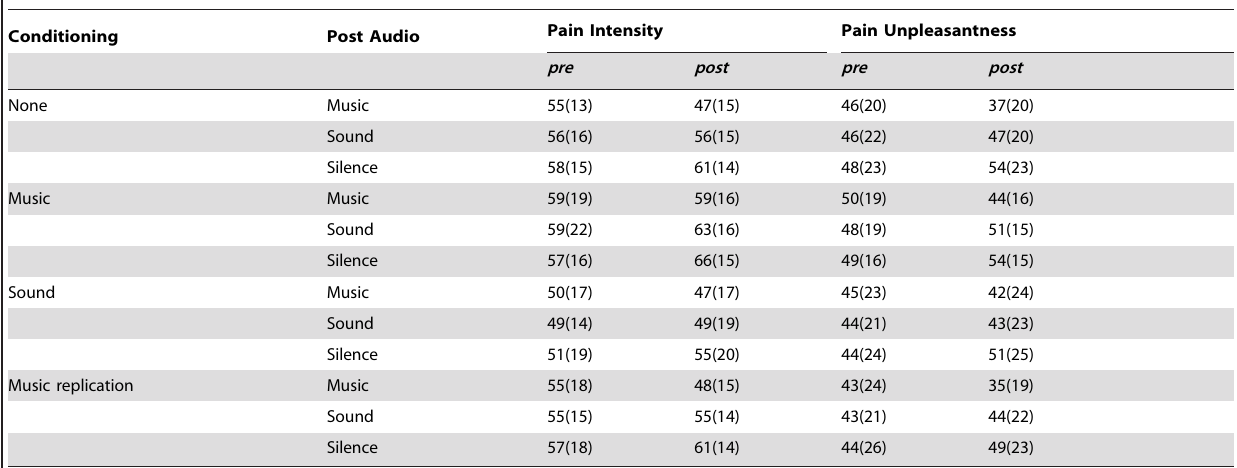
Table 1. Average Pain Ratings for all